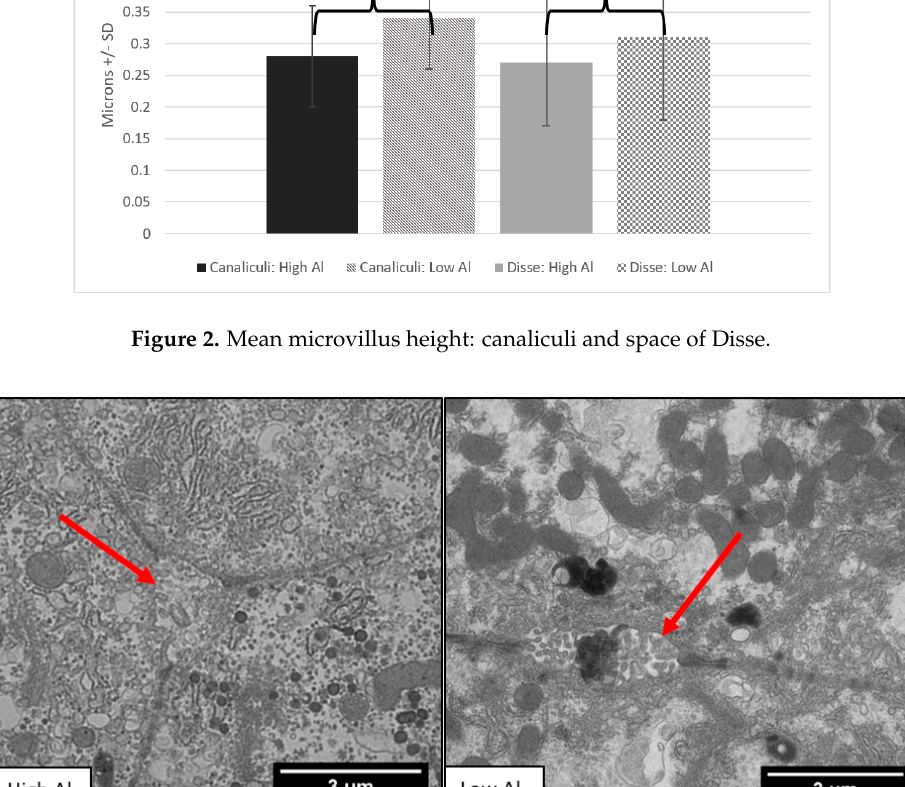
Figure 3. Low vs. High Al transmission electron micrographs with the arrows pointing specifically to the canalicular space. Note that the microvilli in the Low Al canaliculi are longer than in the High Al canaliculi. Both transmission electron micrographs have been taken at the same magnification. Nutrients 2018 , 10 , x FOR PEER REVIEW